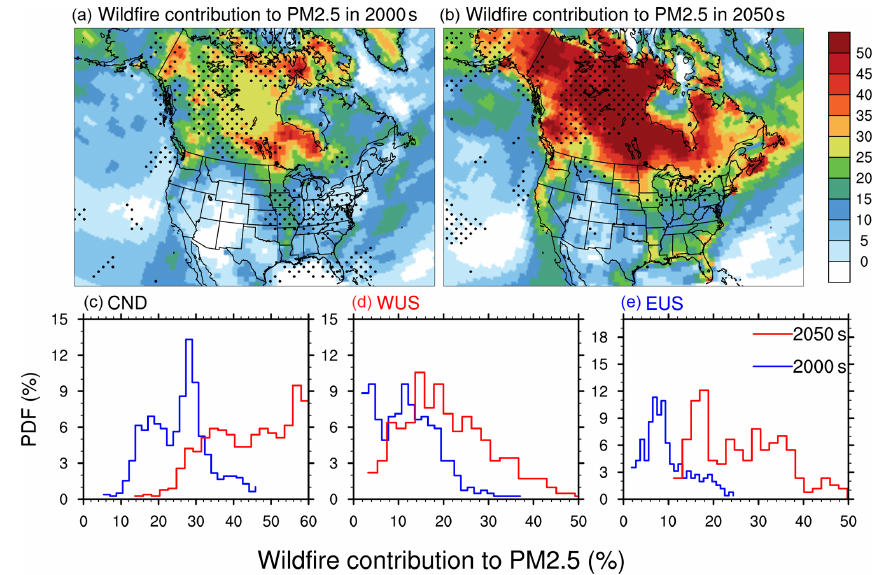
Figure 4. Spatial distribution and probability density function of the percentage contribution of wildfire emissions. (a–b) Spatial distribution of the percentage contribution of wildfire emissions to decadal-averaged summer (JJA) mean PM 2 . 5 concentrations over North America during the present day (a) and the future (b) . The percentage contribution of wildfire-induced PM 2 . 5 to the total PM 2 . 5 concentrations is calculated as (2000 ALL –2000 WEF ) / 2000 ALL and (2050 ALL –2050 WEF ) / 2050 ALL for the present and future, respectively. The grids with statistical significance of 90% are identified by black dots. (c–e) Probability density functions (PDFs) of the percentage of wildfire contribution within the three regions shown in Fig. 2d for Canada (CND: black box) (c) , the WUS (red box) (d) , and the EUS (blue box) (e) , respectively, for the 2000s (blue) and the 2050s (red). Only grids over land in North America are used to generate the PDFs. The y axis indicates the probability of occurrence of different PM 2 . 5 values shown on the x axis.